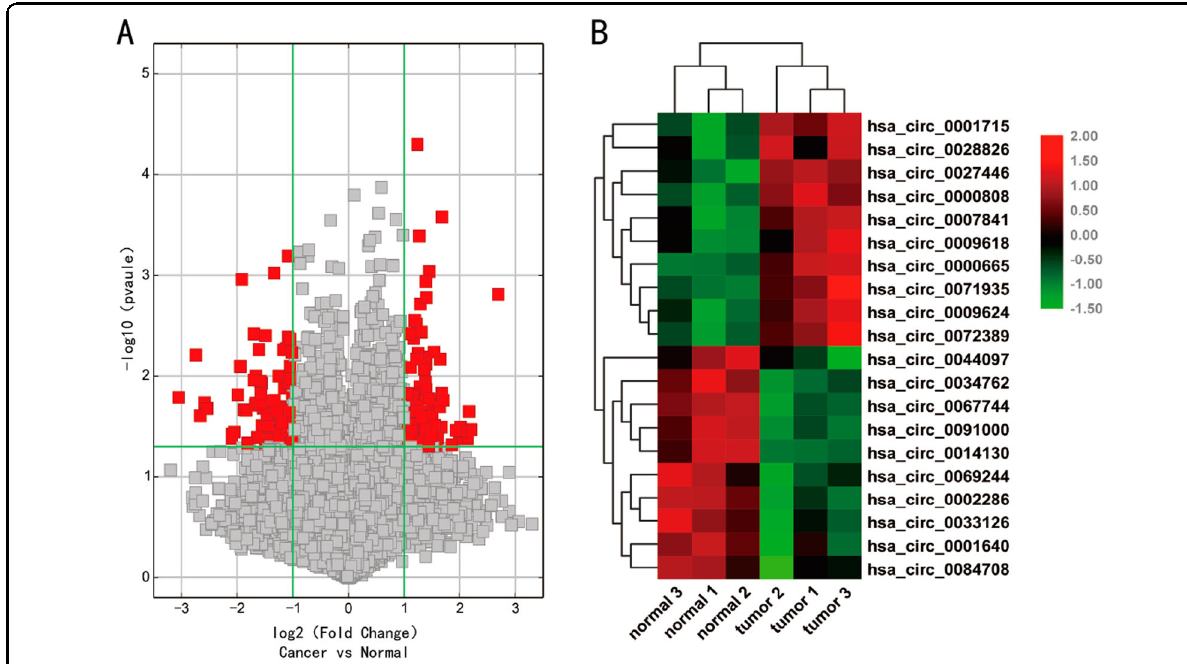
Fig. 1 Differentially expressed circRNAs in LUAD tissues compared to adjacent normal tissues. A According to the criteria of fold change >2.0 and P < 0.05, the signi fi cantly aberrantly expressed circRNAs were selected from the volcano plot. B The heat map shows the top 10 circRNAs with the greatest increases and decreases in expression in 3 LUAD tissues compared to the paired adjacent normal